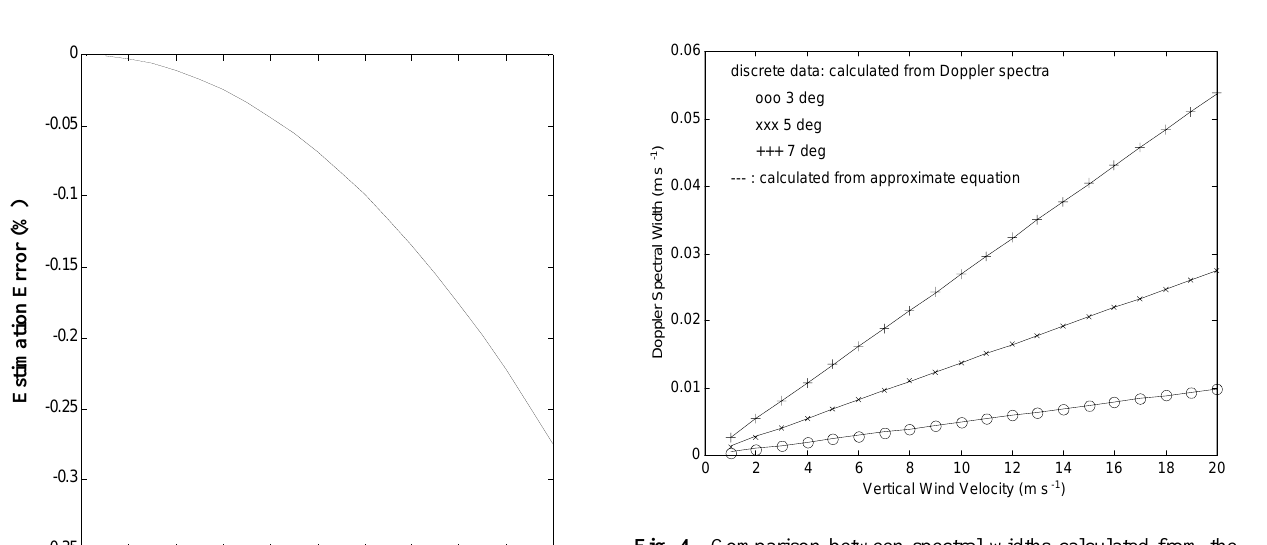
Fig. 4. Comparison between spectral widths calculated from the approximate Eq. (18) (straight lines) and the width of theoretical Doppler spectrum (discrete data point) defined by Eq. (12). It is noteworthy that the magnitude of the spectral width shown in the plot is defined as twice the normalized second moment of Doppler